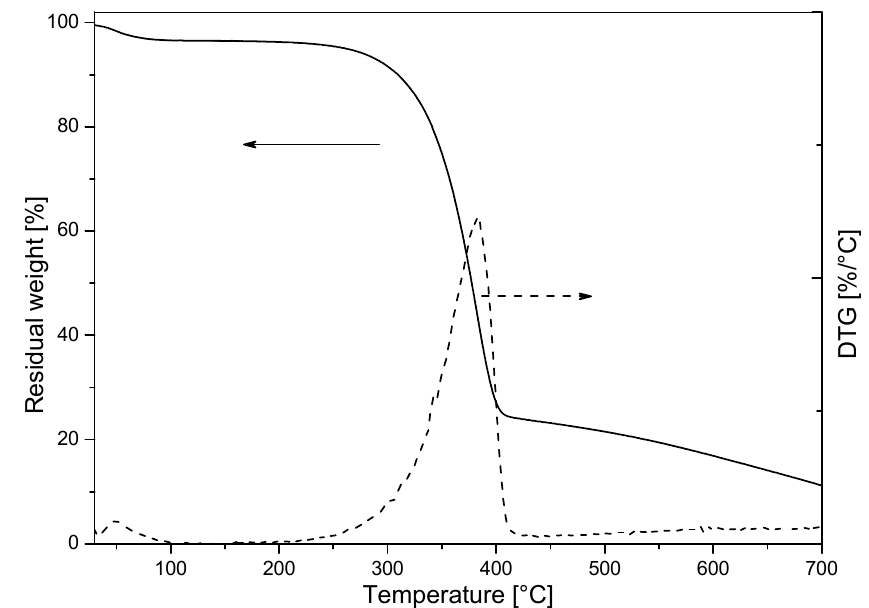
Figure 3. TG and DTG thermograms of dry powdered chitin nanoparticles.